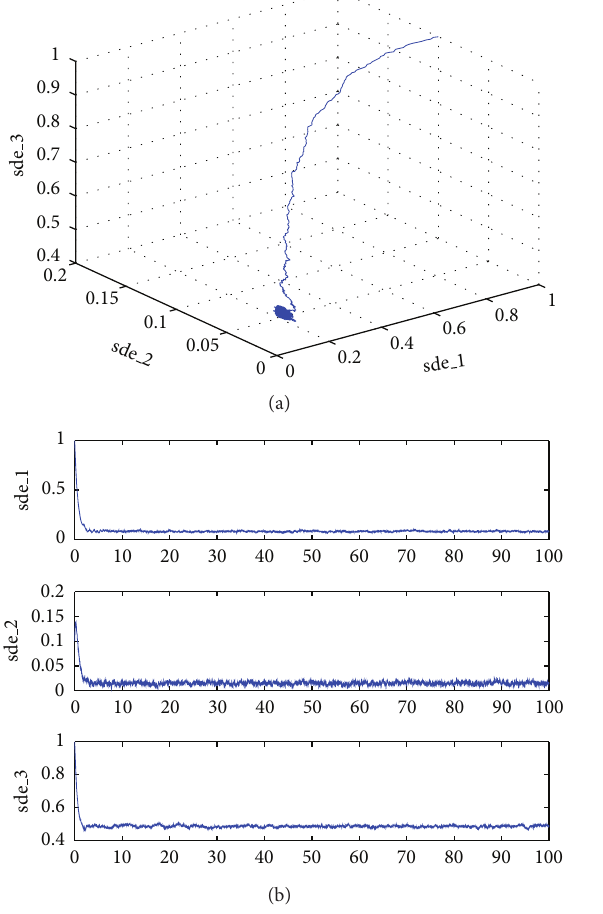
Figure 7: The attractor and the timeseriesof the Stochastic Lorentz- R¨ossler combining system with a white noise 𝑢 𝑖𝑖 = 0.01 , 𝑖 = 1, 2, 3 .